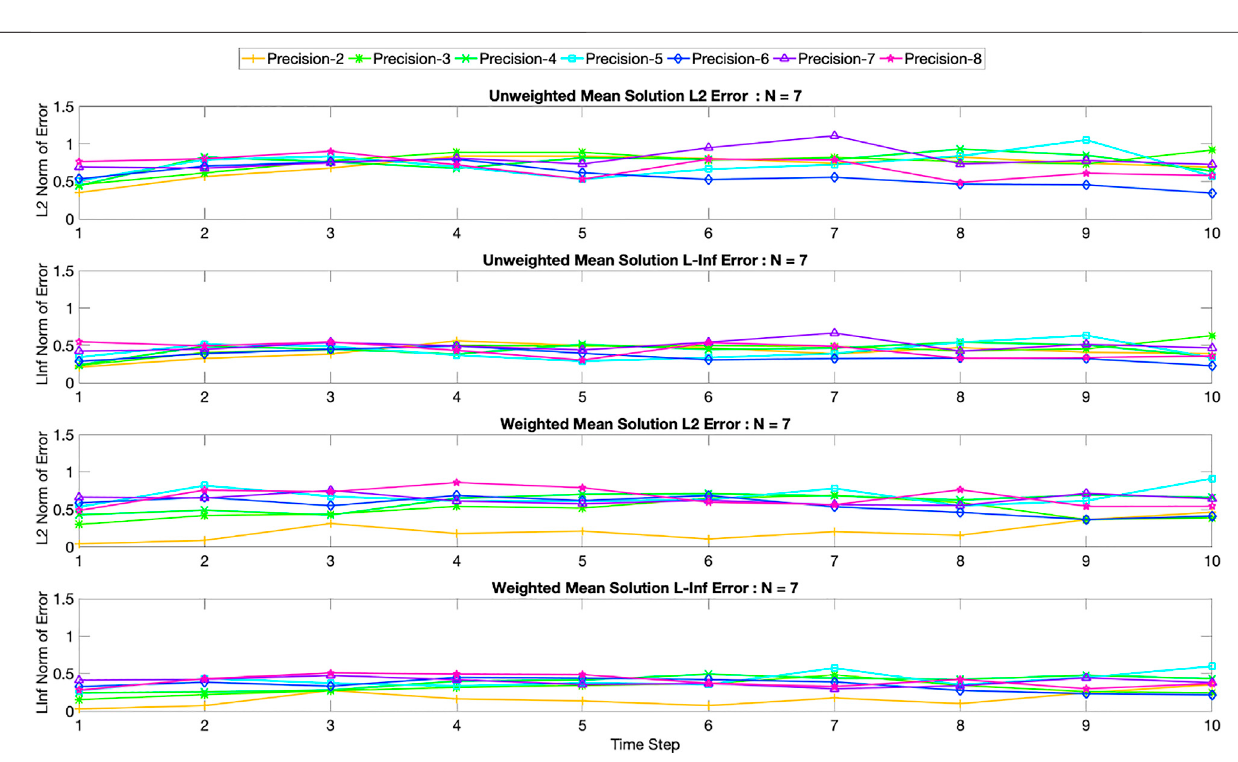
Frontiers in Mechanical Engineering |